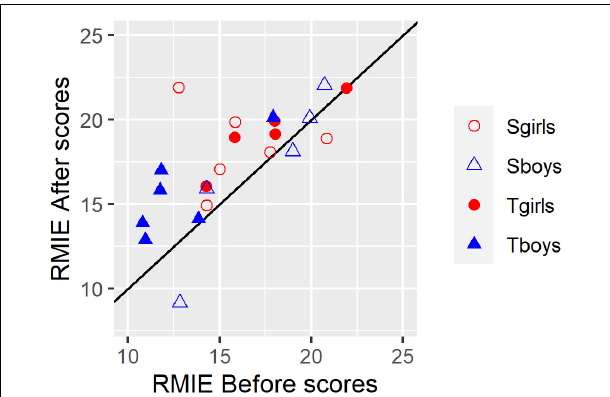
FIGURE 3 | Reading the Mind in the Eyes Test Before and After scores for each of 22 participants. Symbols indicate subgroups. Filled symbols: Turn-taking. Open symbols: Synchrony. Red circles: girls. Blue triangles: boys. Datapoints with identical values are slightly offset on the x -axis so they can be seen. The solid black diagonal line shows x = y , i.e., a symbol appearing on this line indicates no change between Before and After Scores. Higher After than Before scores lie above the line, and lower ones lie below the line.